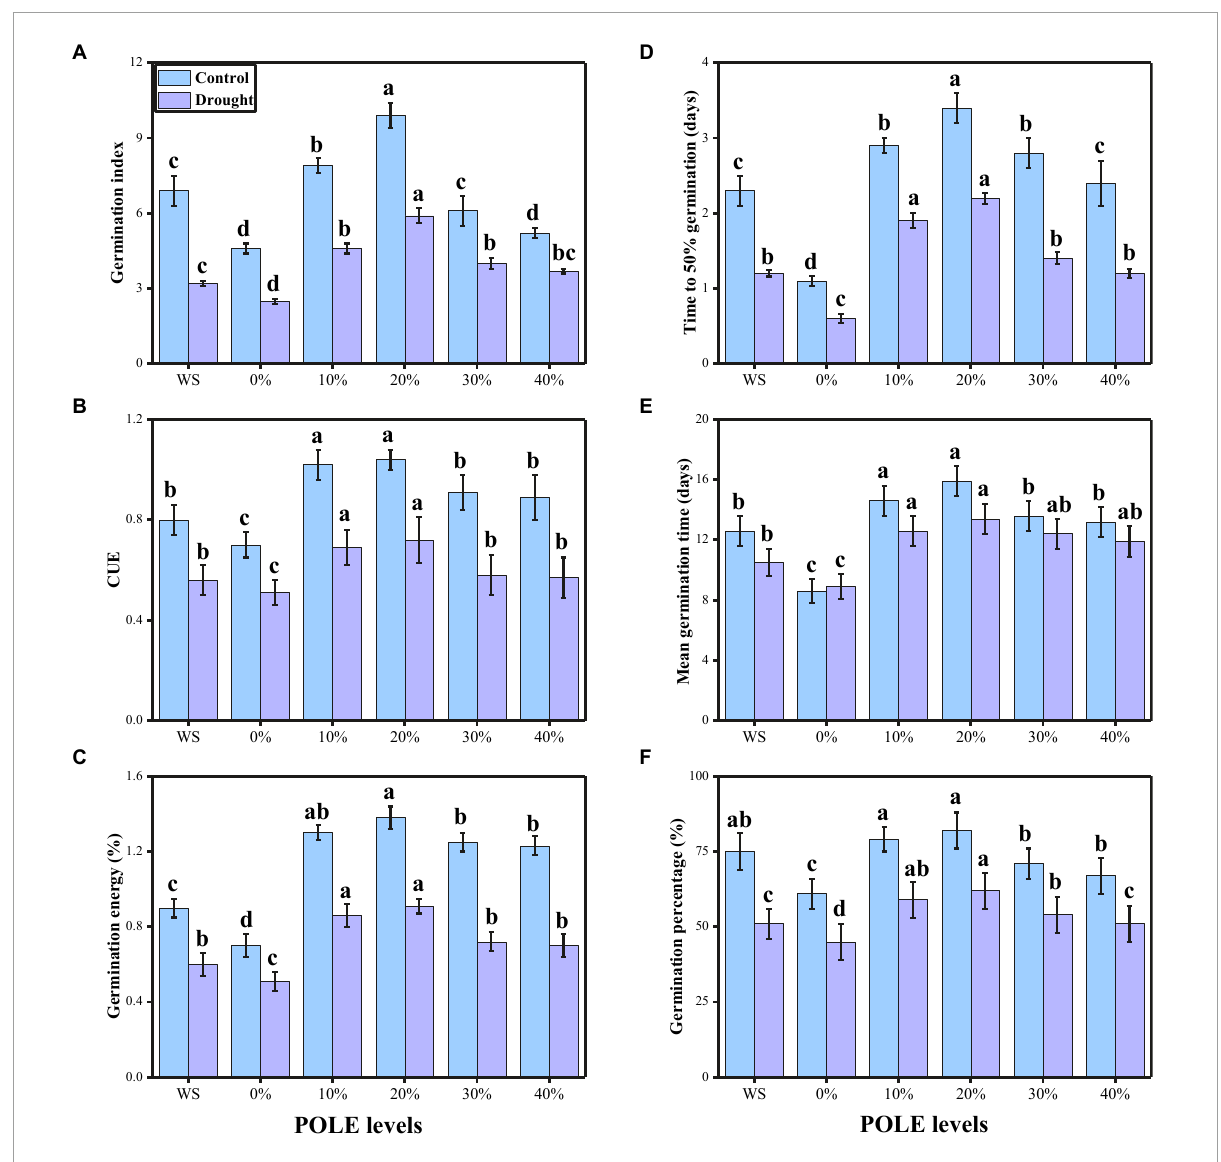
FIGURE1 Effect of seed priming with Plantago ovata Forsk leaf extract (POLE) on germination index (A) , time to total 50% germination (B) , co-efficient of uniformity of emergence (C) , mean germination time (D) , germination energy (E) , and germination percentage (F) under well-watered and drought-stressed environment in wheat. Means sharing similar letter(s) within a column for each parameter do not differ significantly at P < 0.05. Data in the figures are means of four repeats ( n = 4) of just one harvest of wheat plants ± standard deviation (SD). Different lowercase letters on the error bars indicate significant difference between the treatments. Different treatments of POLE used in this study are as follows: WS (Control, without POLE + without water), 0% (0% POLE), 10% (10% POLE), 20% (20% POLE), 30% (30% POLE), and 40% (40% POLE).